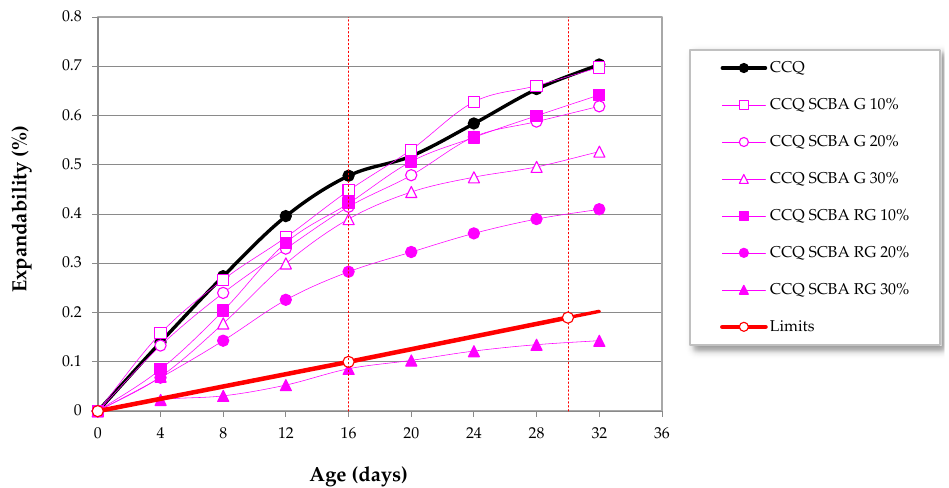
Figure 16. Comparison between the expandability of mortars developed with quartzite aggregates.